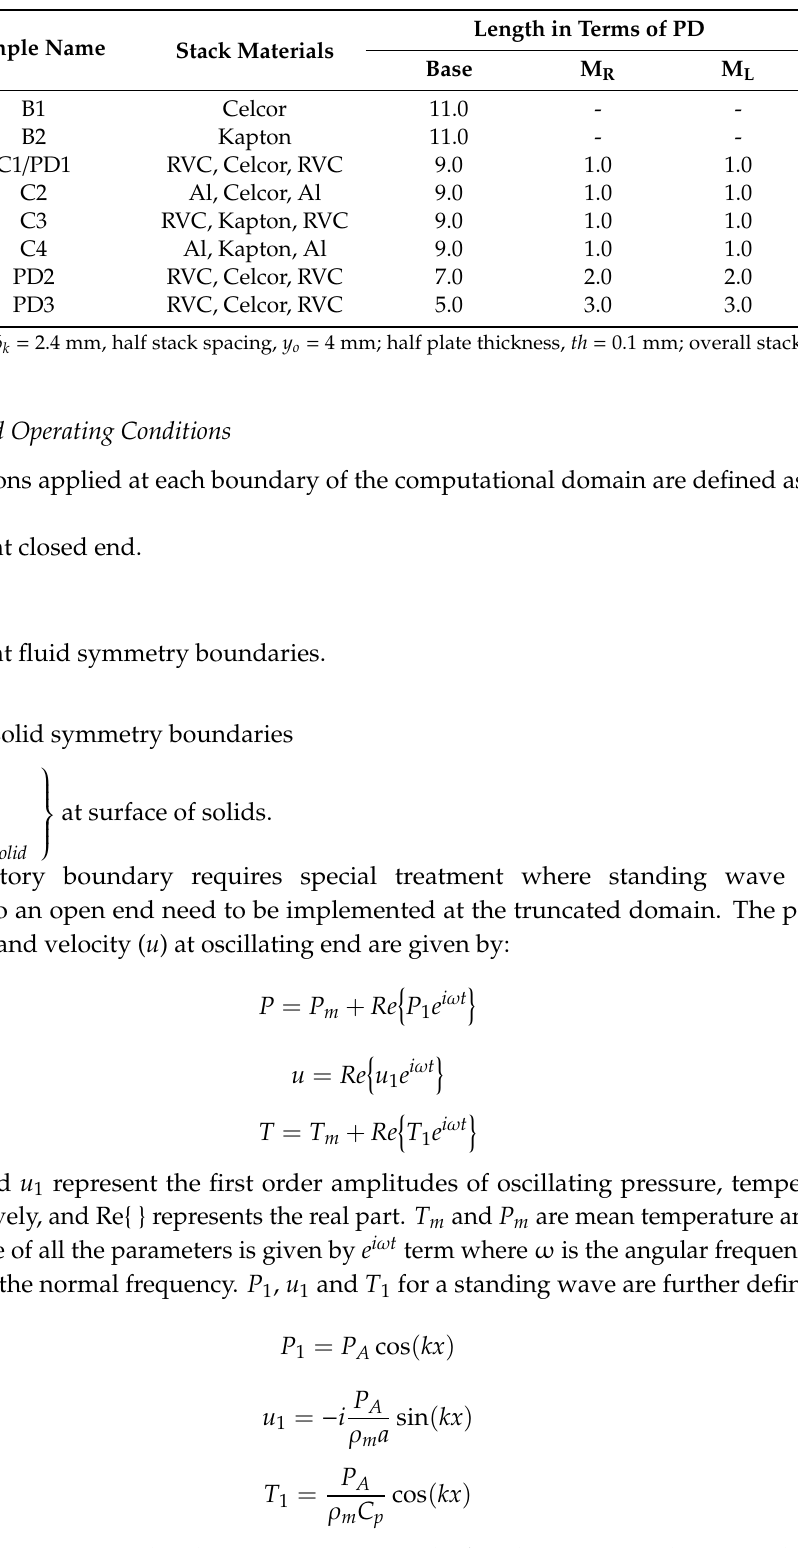
Table 1. Details of all test cases simulated in the current